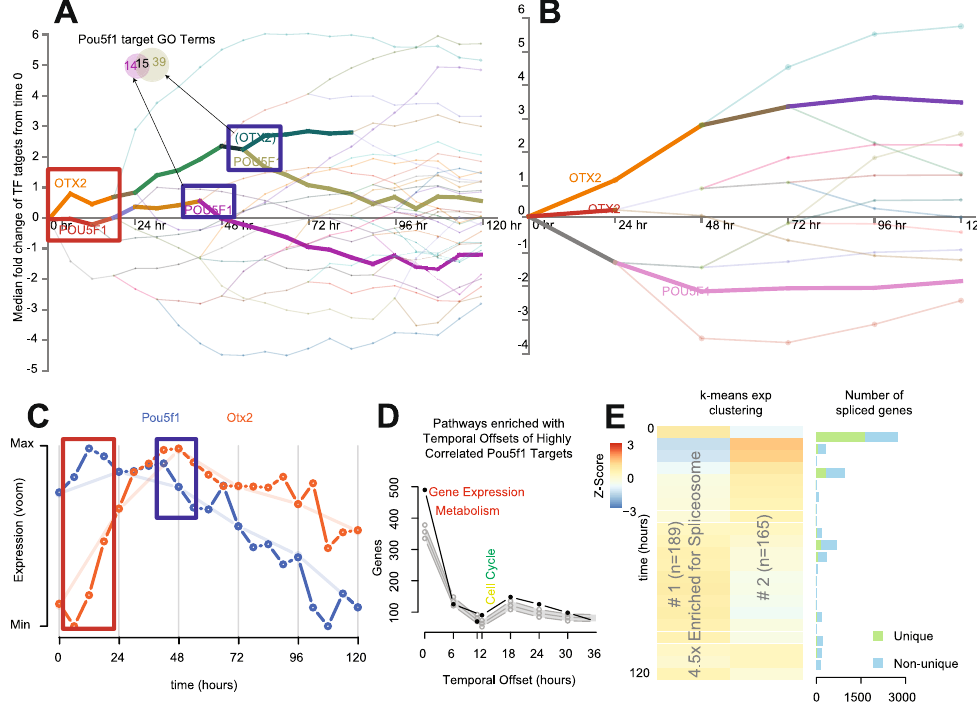
Figure 2. Insights into regulatory and gene expression kinetics. ( A and B ) Observable regulatory network dynamics at 24- and 6-hourly measures with Otx2 and Pou5f1 target containing profiles annotated and in bold, See Supplementary Fig. S2 for full figure. Transcriptomes at 24- (top) and 6-hourly (bottom) were subjected to DREM analysis of mouse TF/target gene interactions. Lines represent the median fold change (relative to time 0) of grouped TF target genes- representing activity of the TF itself, line colors are assigned by branch and are not comparable between panels. A p-value cutoff of 0.001 was applied to calculating divergent TF activity (splits). ( C ) Expression of the key transcription factors Pou5F1 ( Oct4 ) and Otx2 . Red and blue boxes correspond to the time points highlighted in part A. ( D) Distribution of the number of genes and the time delay required to meet a maximum correlation ( > 0.8) between gene targets of Pou5f1 and Pou5f1 itself compared to 95% quantiles of 500 random gene selections. ( E) Two k-means clusters of short-lived RNA (slRNA) genes displaying differential expression without changes at 24-hourly time points (adj. p <